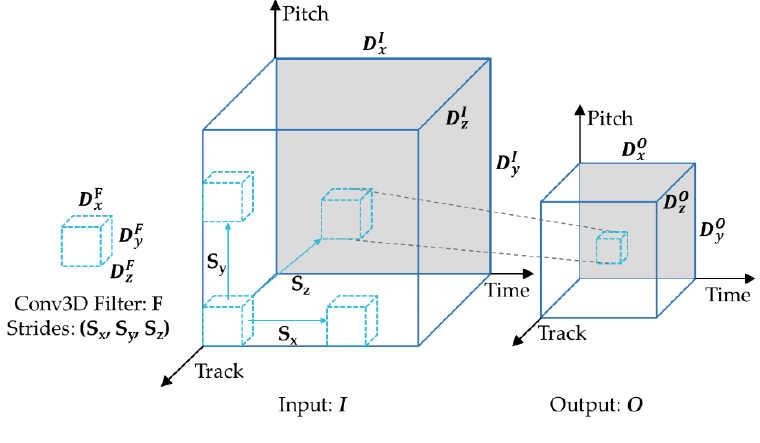
Figure 3. Structure of Conv3D.